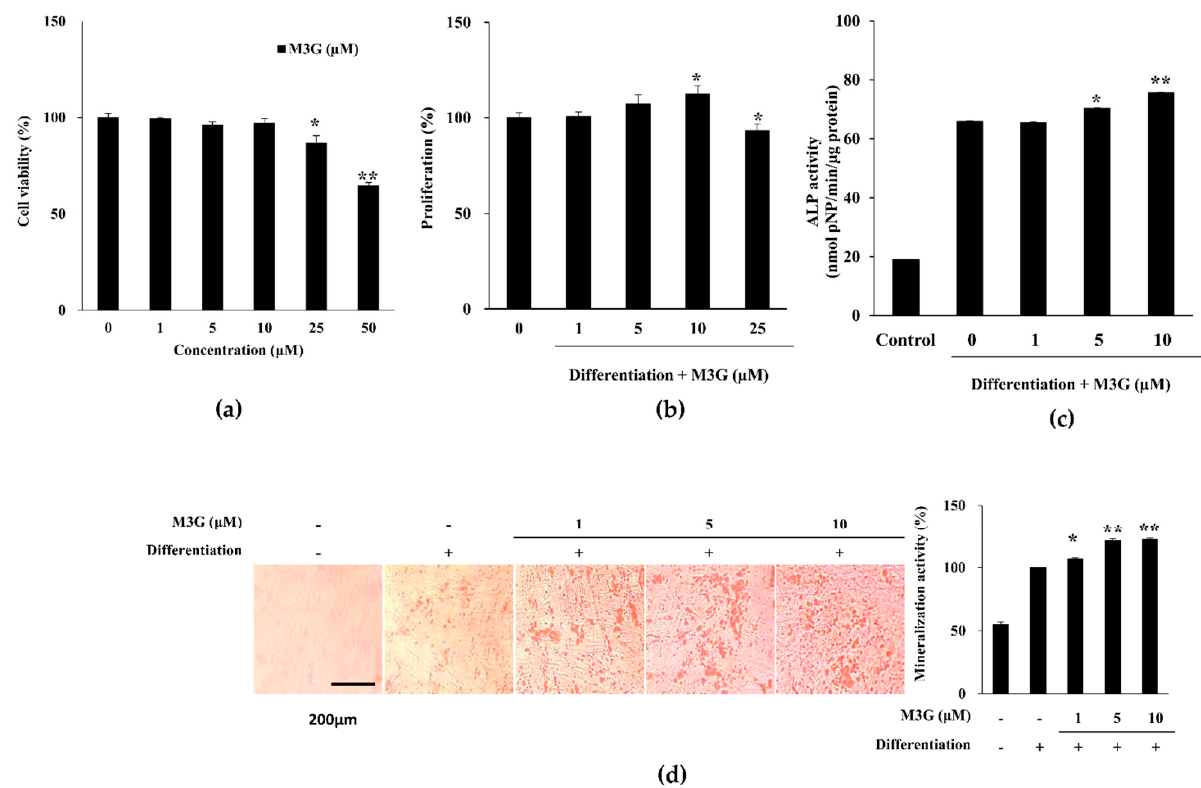
Figure 2. Effect of M3G on the osteoblastogenic differentiation of hBM-MSCs. Effect of M3G on the ( a ) viability of non-differentiated hBM-MSCs and ( b ) proliferation of osteo-induced hBM-MSCs. Viable cell amount was measured by quantification of MTT dye removed from cells at day 3 of differentiation. Proliferation was given as relative viable cell amount (%) of untreated osteo-induced control. ( c ) Effect of M3G on the activity of cellular ALP. Cellular ALP activity of osteo-induced hBM-MSCs was measured with a spectrophotometric enzymatic activity assay at day 7 of differentiation. M3G was present in the first 3 days of differentiation only. Control: Non-differentiated untreated cells in culture medium. ( d ) Effect of M3G on the extracellular mineralization of osteo-induced hBM-MSCs. Extracellular mineralization was measured by Alizarin Red staining and quantified by the absorbance values of the retained dye at day 10 of differentiation. Mineralization was given as a relative percentage of untreated osteo-induced hBM-MSCs. M3G was treated in the first 3 days of differentiation only. * p < 0.05, ** p < 0.01 vs. differentiated untreated group.